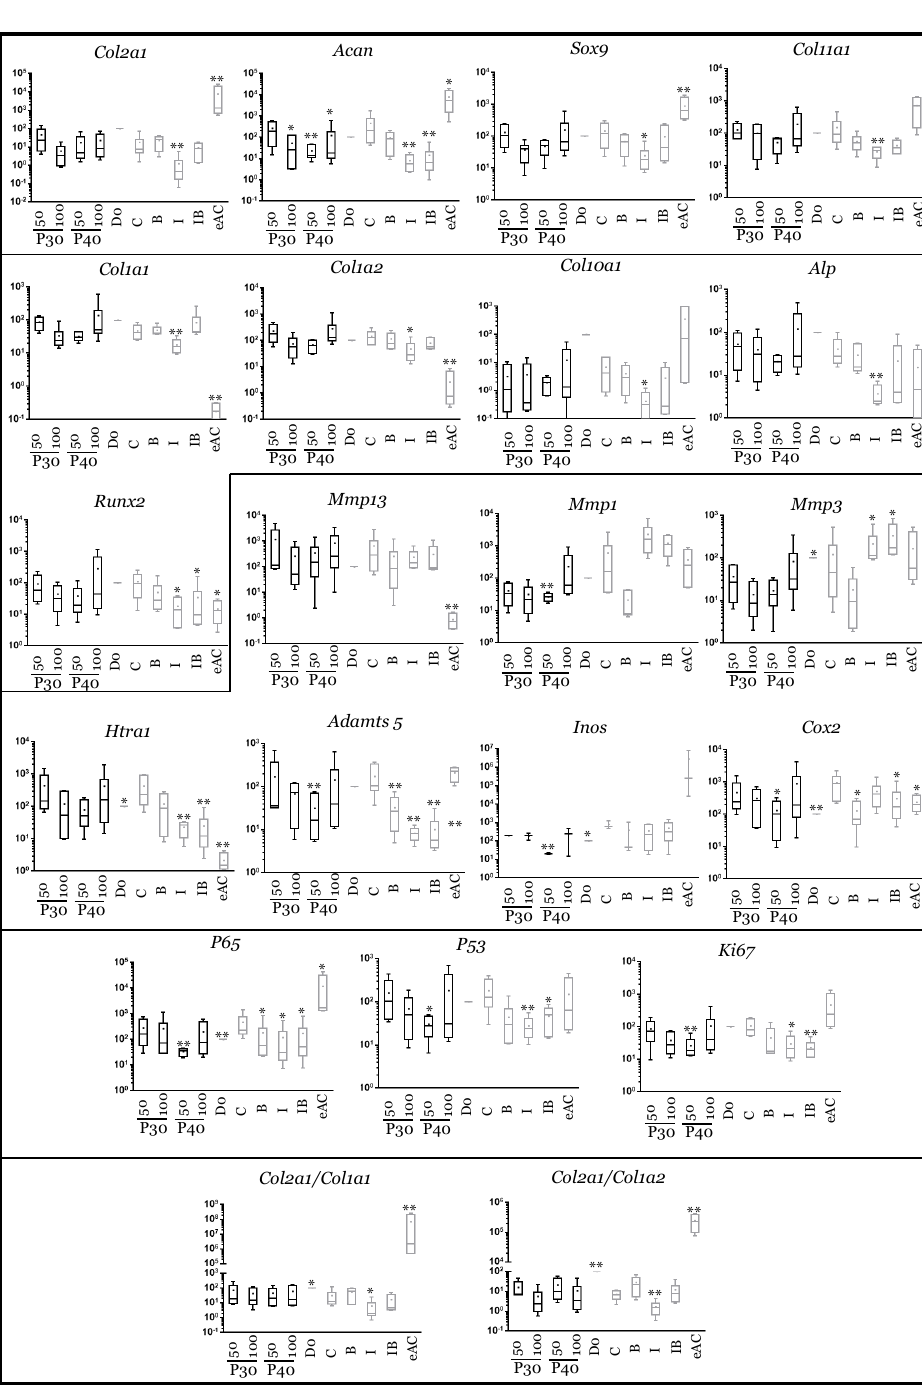
mRNA was extracted as described in Materials and Methods. The mRNAs were estimated using RT-qPCR after normali- zation with respect to the β -actin reference gene. Transcript expression is shown in arbitrary units. The Col2a1 : Col1a1 and Col2a1 : Col1a2 ratios are given. The results are shown as histograms and the significance of the values between the different treatments and the control (C) was tested using a Mann–Whitney test; n = 3. eAC: mRNA extracts obtained from equine articular chondrocytes released from cartilage after overnight enzymatic digestion were used as controls. D0: cells seeded in sponges and arrested after 16 h of incubation.